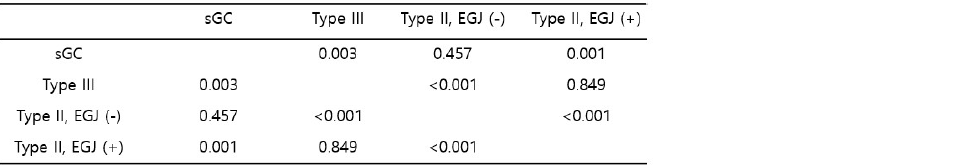
Figure 2. ( A ) Overall survival of cardia or subcardia cancer patients. ( B ) Overall survival of cardia or subcardia cancer patients categorized by EGJ invasion. EGJ: esophagogastric junction; sGC: subcardia gastric cancer without esophagogastric junction invasion.